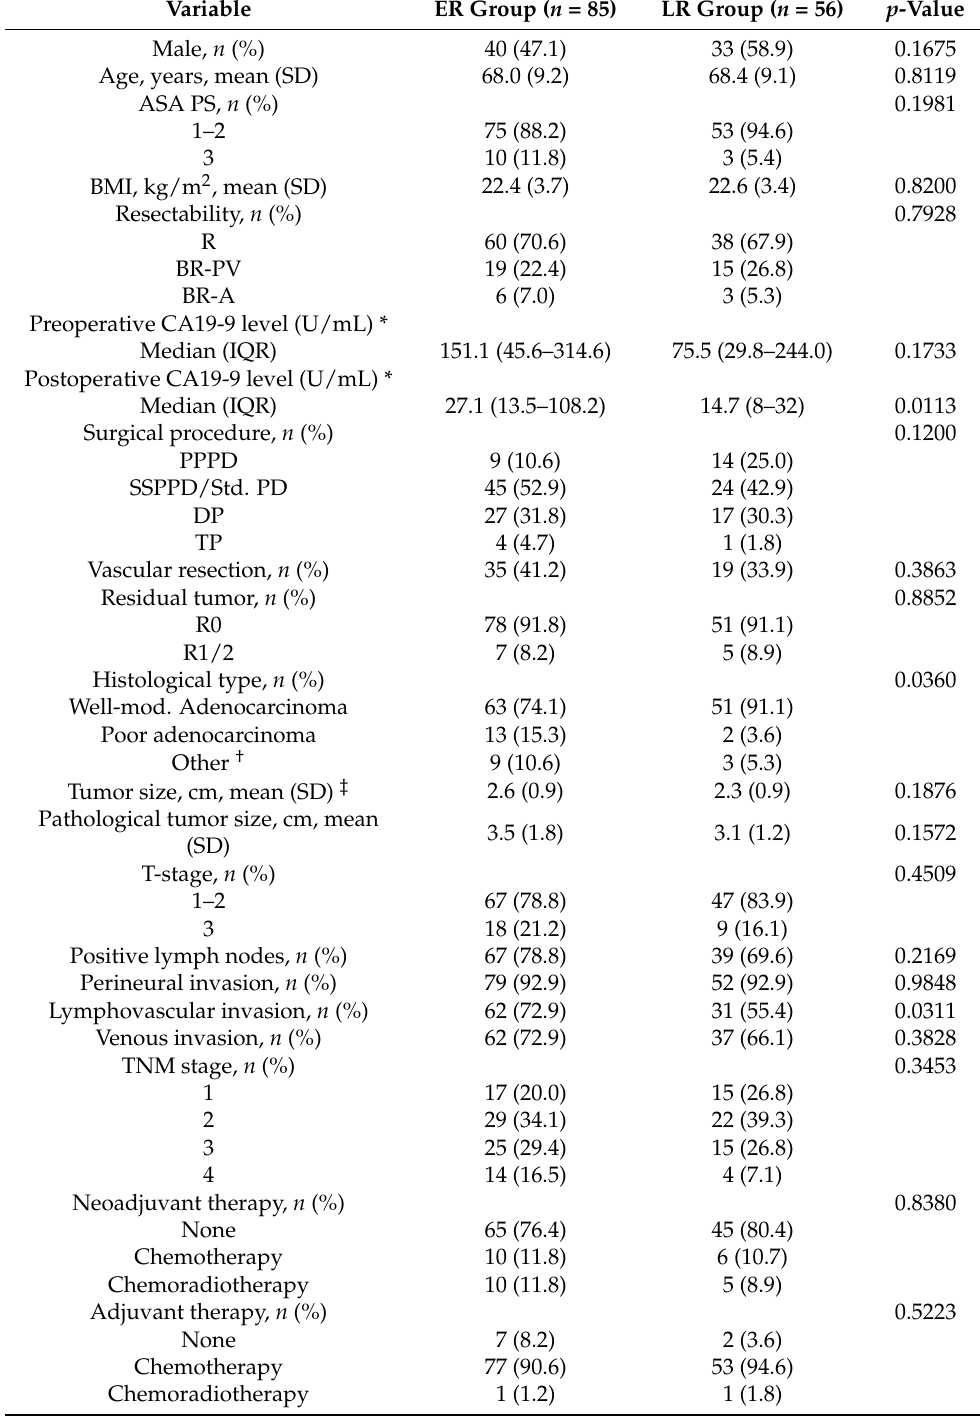
Table 2. Demographic, clinicopathological and treatment characteristics of patients with